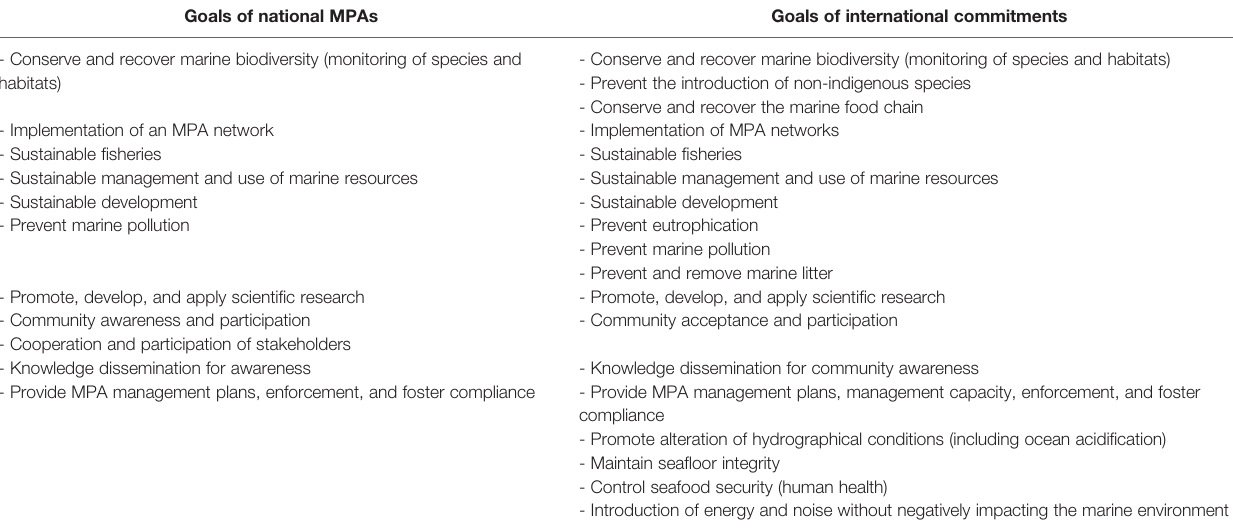
TABLE 2 | General description of the goals of national MPAs and international commitments, adapted from their instruments. Goals of national